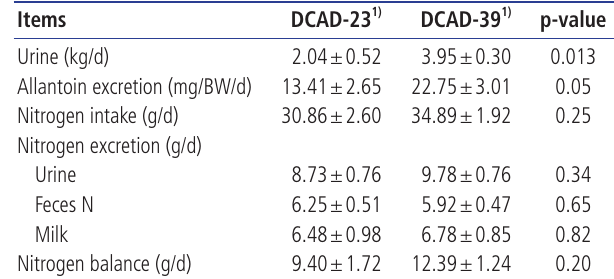
Table 3. Effects of dietary cation and anion difference on ruminal fermentation characteristics in dairy goats Table 4. Effects of dietary cation and anion difference on urinary allantoin excretion and nitrogen balance at 8th weeks postpartum in dairy